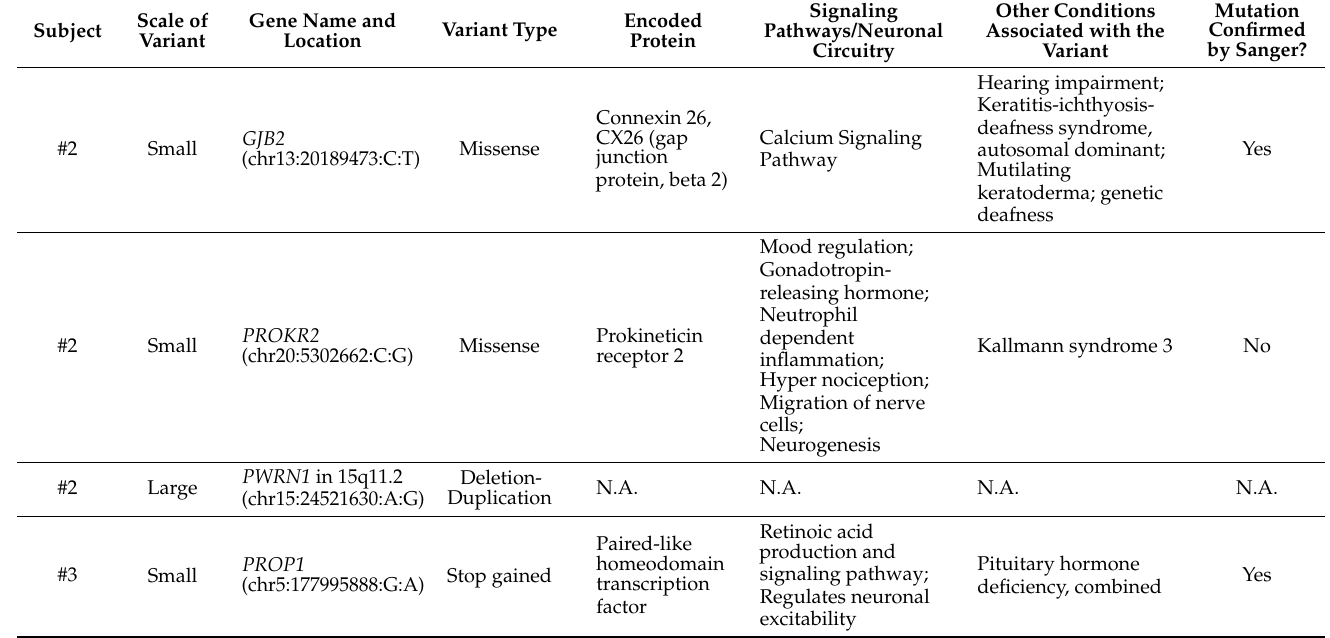
Table A1. Summary of all variants and results of Sanger sequencing (includes variants not presented in Table